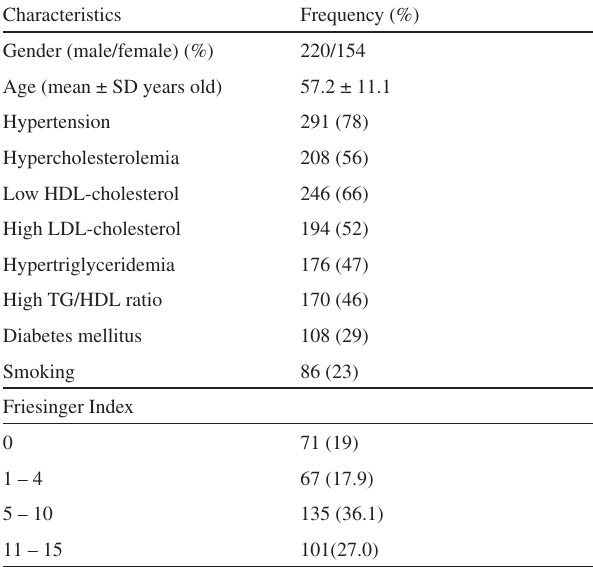
Table 1 - Demographic characteristics of patient sample and